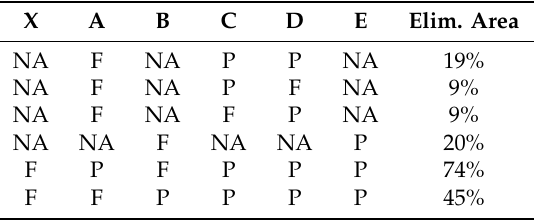
Table 3. Evaluation of Location of underperforming area